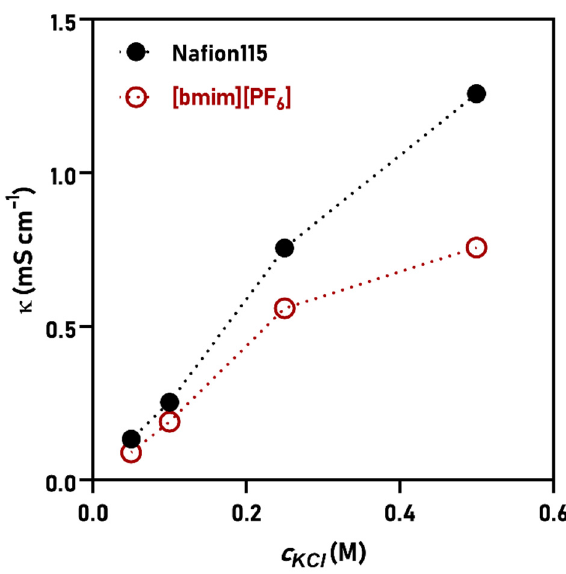
Figure 5. The dependence of conductivity on the electrolyte concentration in the cases of Nafion and [bmim][PF 6 ]-SILM.